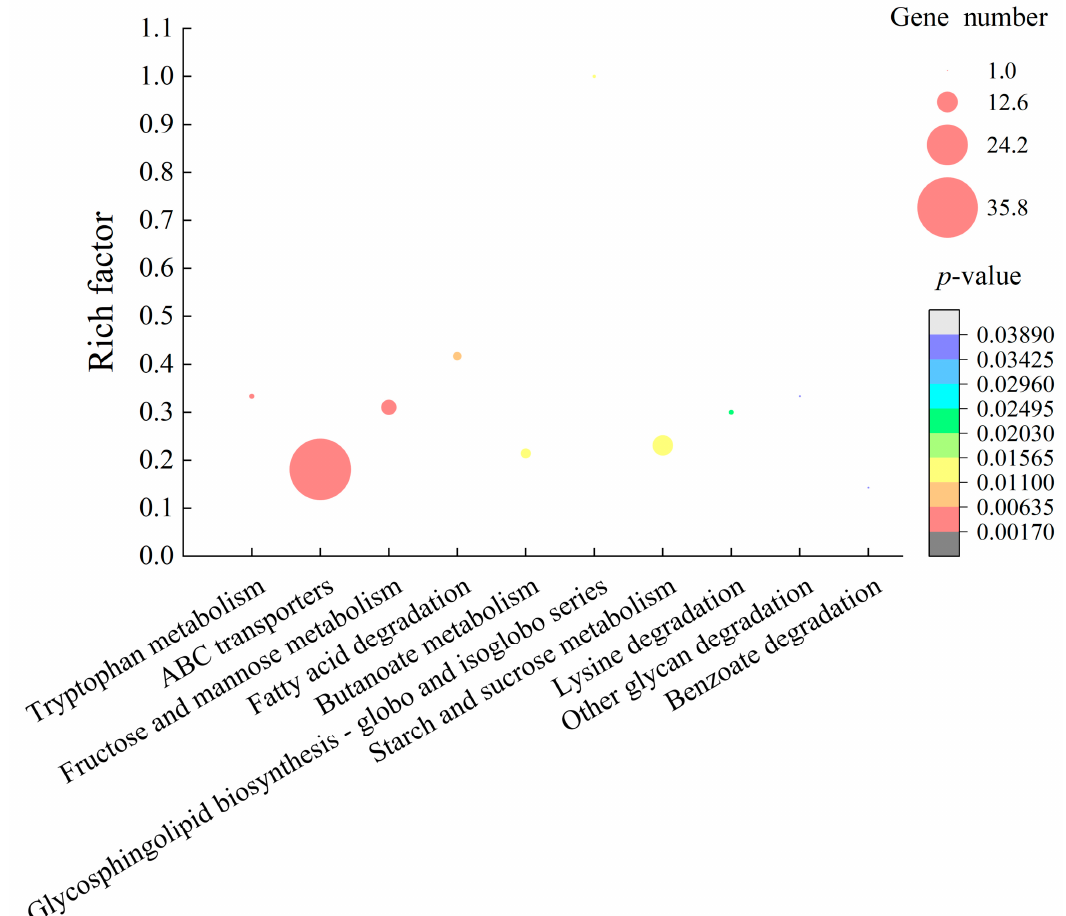
Figure 6. The significantly altered metabolic pathways in E. sakazakii CMCC45401 mediated by the GMPE.